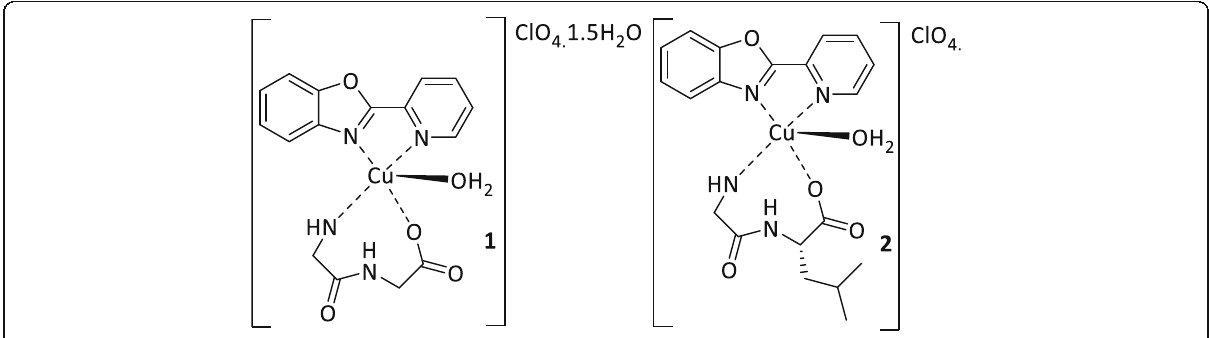
Fig. 44 Cu(II)-Dipeptide-benzoxazole